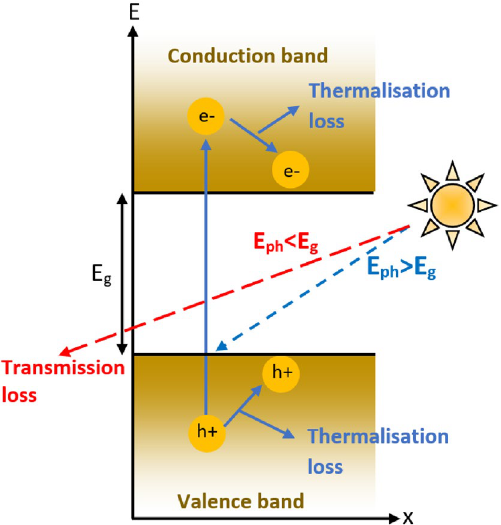
Figure 1. Schematic representation of power losses in single-junction solar cells viz. thermalization and transmission